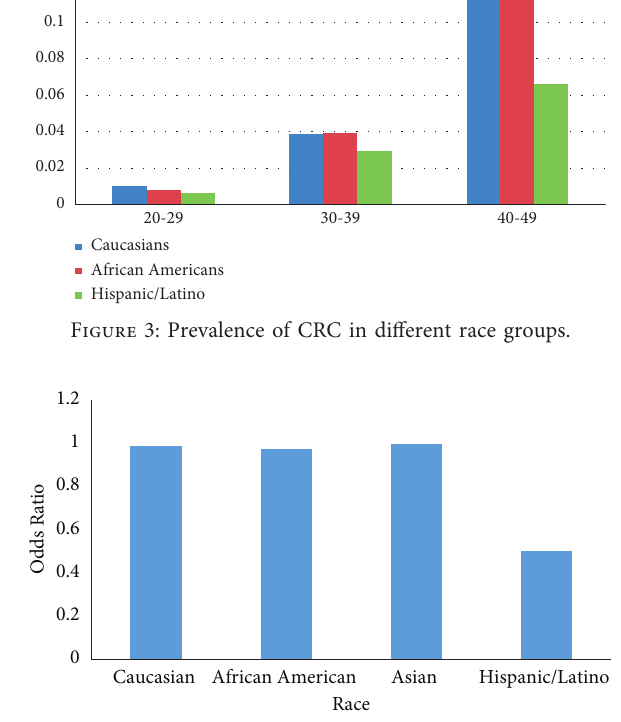
Figure 4: Odds ratio of CRC in different race